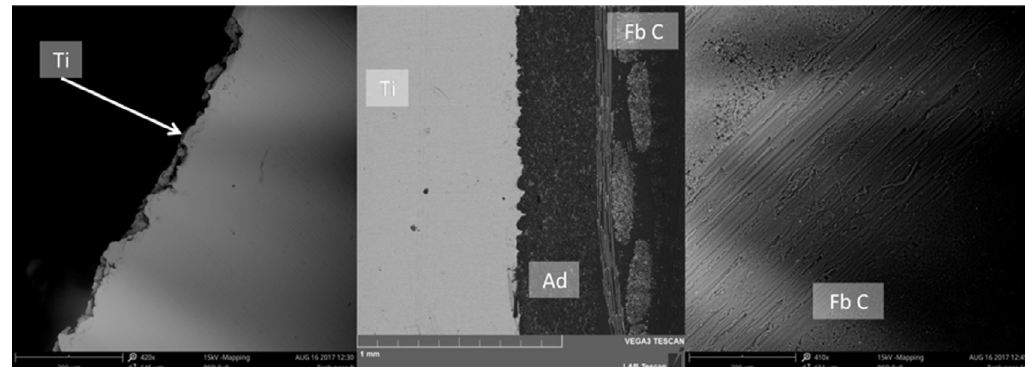
Figure 11. Resulting burrs from machining trials. On the left, titanium (a), center: titanium, adhesive and carbon fiber (b); and right: carbon fiber. Subtitles: Ti – titanium, Fb C – carbon fiber and Ad – adhesive. Images obtained by scanning electron